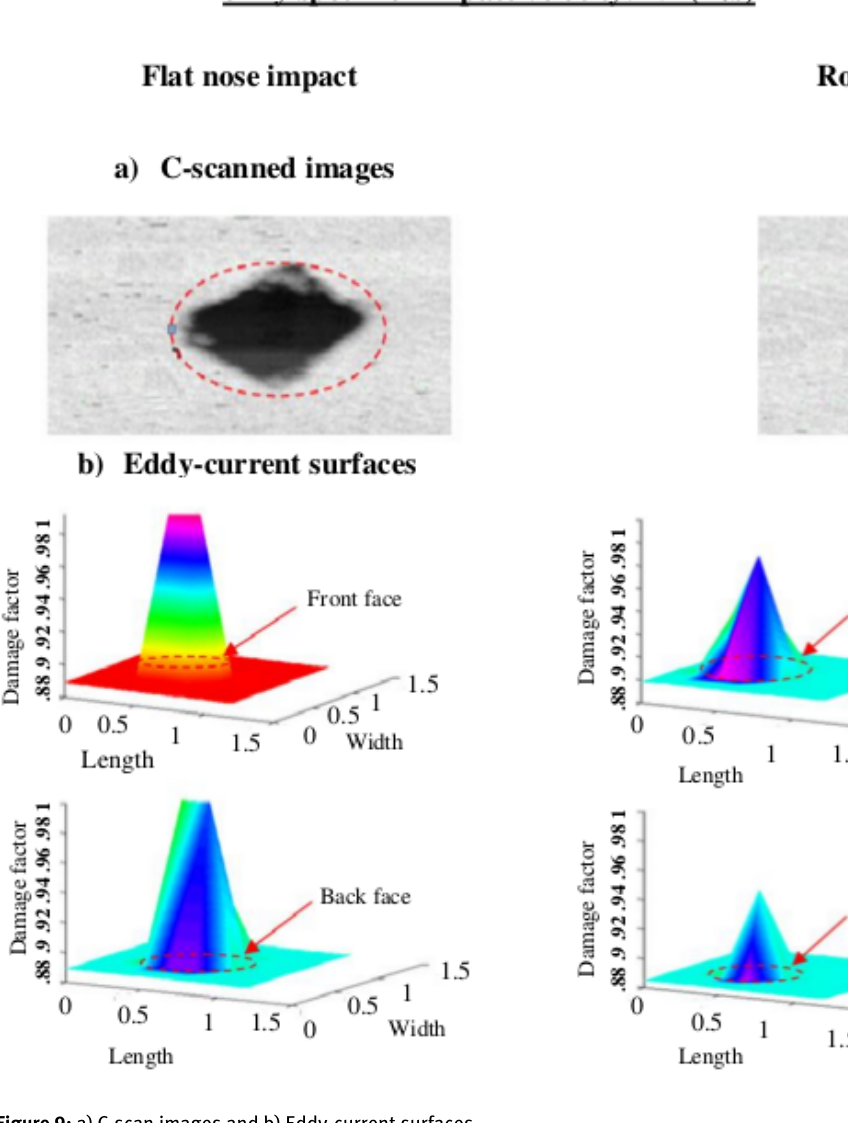
Figure 9: a) C-scan images and b) Eddy-current